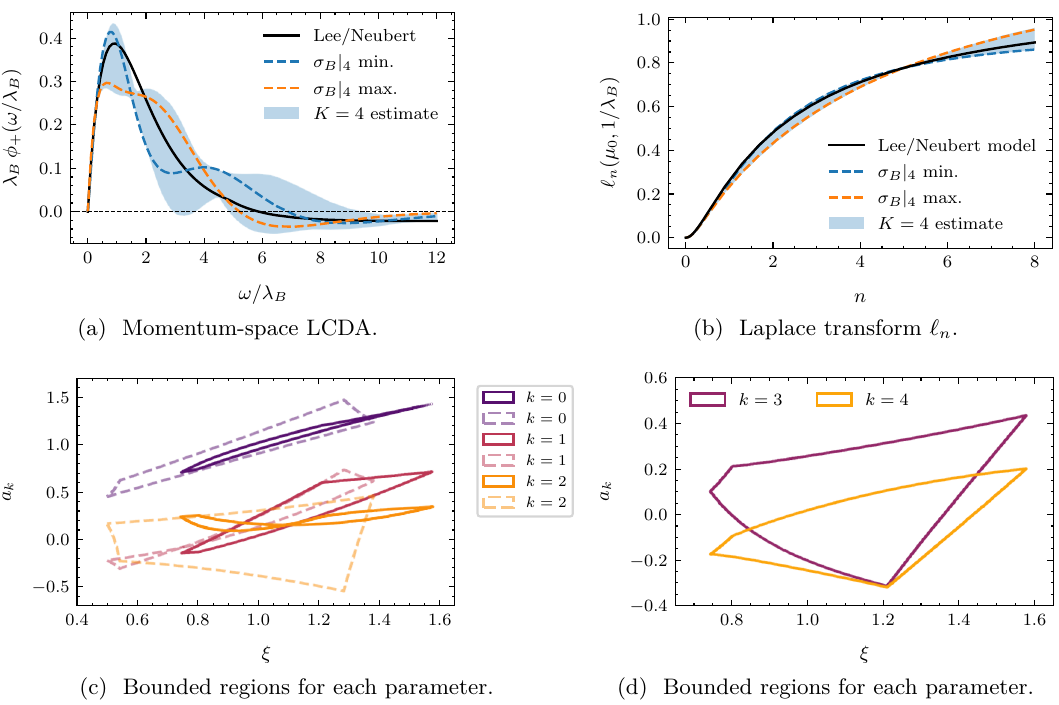
Figure 8 . Results from the pseudo-fit employing theoretical constraints in addition to the phe- nomenological inputs p and p . The dashed regions in figure 8c correspond to the pseudo-fit without 1 2 theoretical OPE